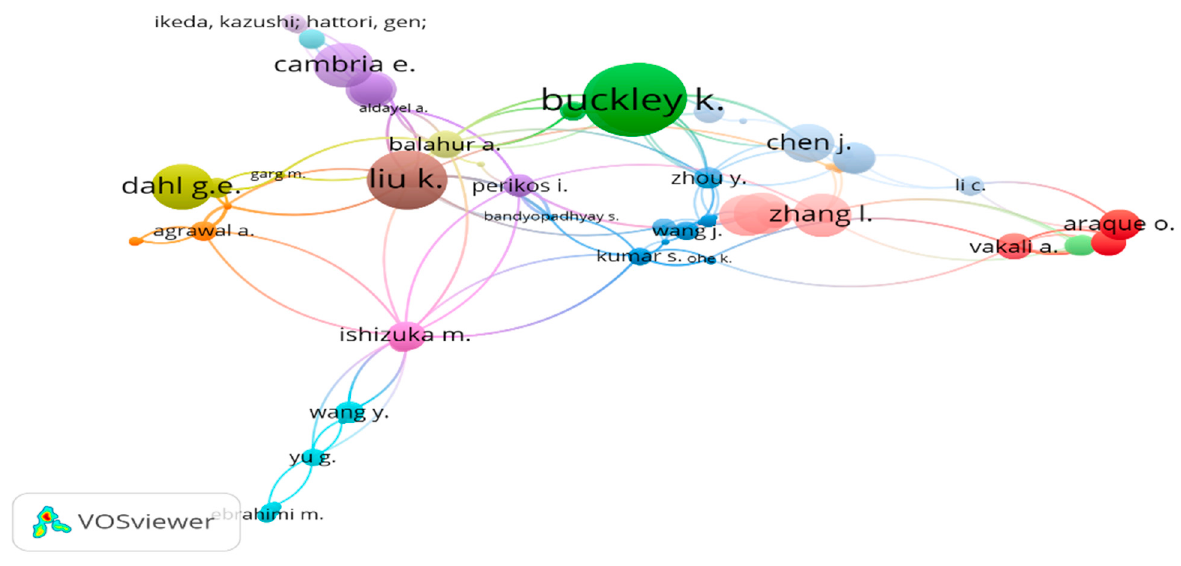
Figure 19. Highest cited authors using a network graph. Table 19. Highly cited authors, links, and